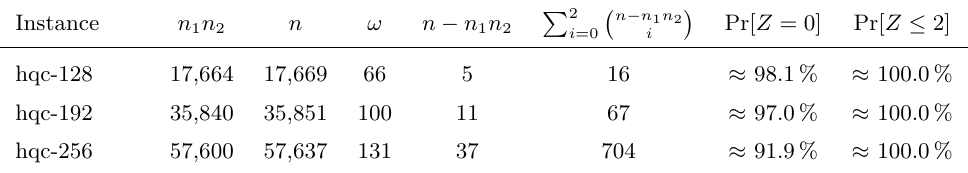
Figure 2: An element of F 2 [ x ] / h x n − 1 i and its segmentation into codewords of the inner code. Table 4: Remaining n − n 1 n 2 bits that must be recovered for each parameter set, the number of ways to pick the remaining bits with a weight of up to 2, the probability that the weight is 0, and the probability that the weight is ≤